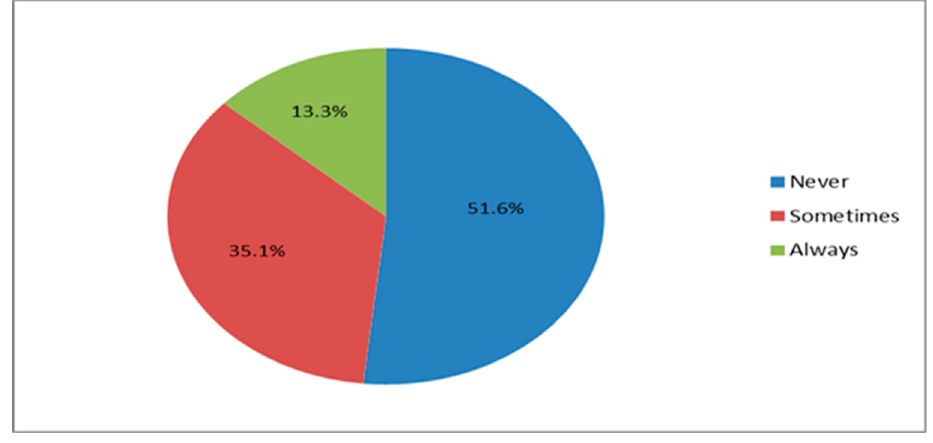
Figure 1. Diagram showing how often participants wash their hands after outings and how often they eat with their hands. eat with their hands.